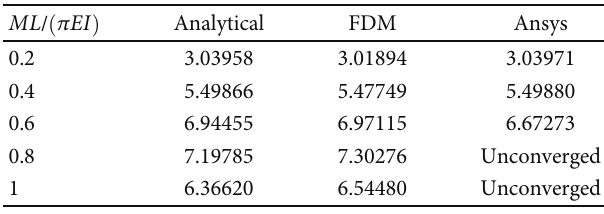
Table 2: Comparison of tip vertical displacement using FDM and Ansys (m).